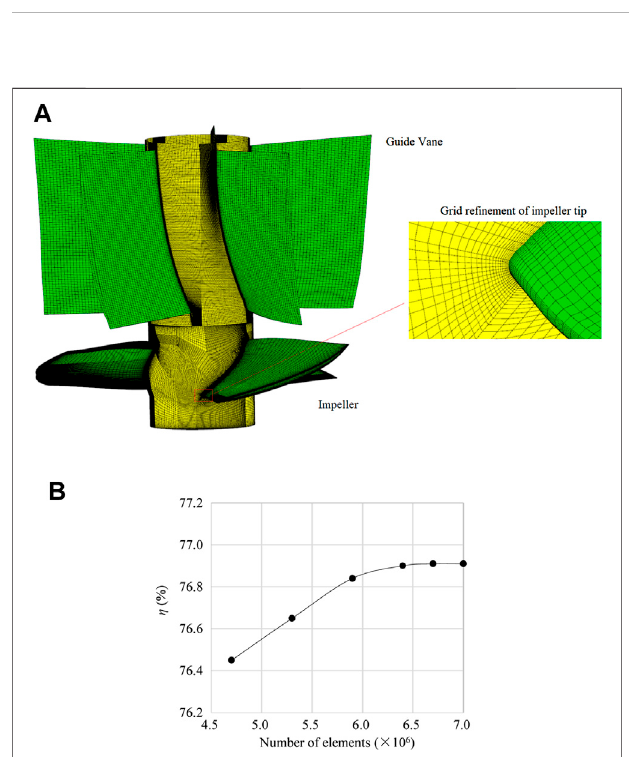
FIGURE 2 | (A) Mesh generation. (B) Grid independence analysis.